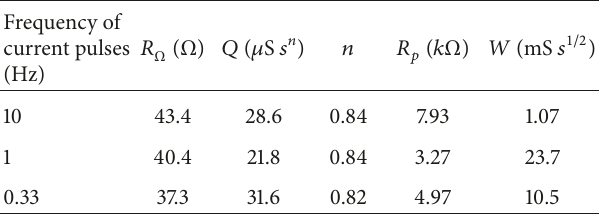
Table 2: Impedance parameters obtained using the circuit model of Figure 7(b). Frequency